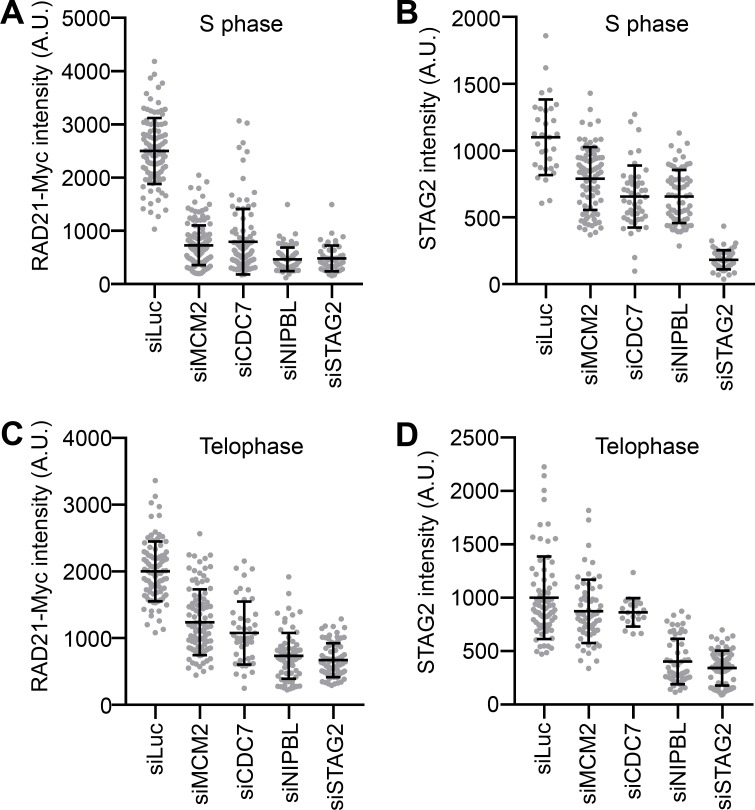
DDK promotes cohesin loading in early S phase, but not in telophase.(A) Quantification of the intensities of chromatin-bound RAD21-Myc of cells in Figure 3A. Each dot in the graph represents a single cell. Mean ± SD (siLuc, n = 101; siMCM2, n = 141; siCDC7, n = 102; siNIPBL, n = 69; siSTAG2, n = 52). (B) Quantification of the intensities of chromatin-bound STAG2 in HeLa cells transfected with the indicated siRNAs and synchronized in early S phase by thymidine. Mean ± SD (siLuc, n = 31; siMCM2, n = 84; siCDC7, n = 47; siNIPBL, n = 66; siSTAG2, n = 62). (C) Quantification of the intensities of chromatin-bound RAD21-Myc in telophase HeLa cells that stably expressed RAD21-Myc and were transfected with the indicated siRNAs. Mean ± SD (siLuc, n = 90; siMCM2, n = 96; siCDC7, n = 45; siNIPBL, n = 75; siSTAG2, n = 76). (D) Quantification of the intensities of chromatin-bound STAG2 in telophase HeLa cells transfected with the indicated siRNAs. Mean ± SD (siLuc, n = 74; siMCM2, n = 61; siCDC7, n = 20; siNIPBL, n = 58; siSTAG2, n = 69).